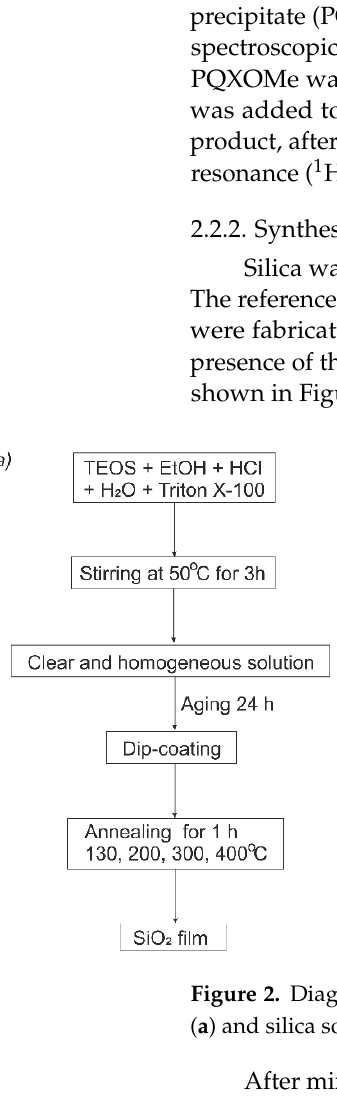
Figure 1. Reactions in synthesis of PQX-OH.